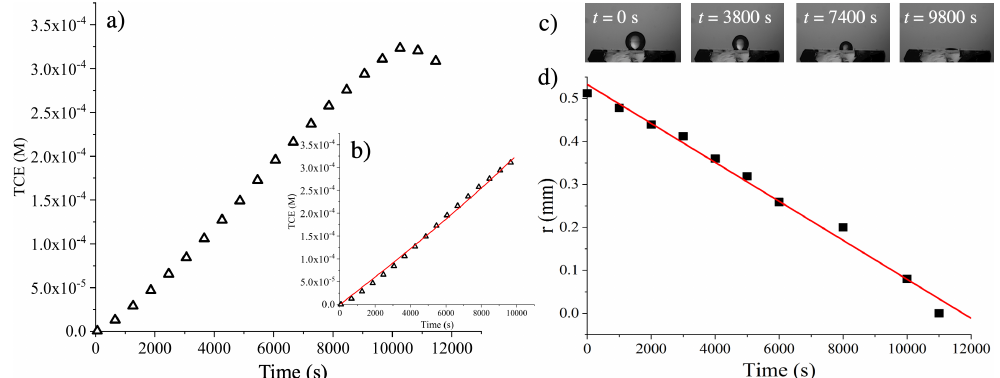
Figure 3. Experimental results in pure water. ( a ) Change of [TCE] in the bulk during an experi- ment in pure water at T = 23 ◦ C and 2010 rpm; ( b ) fitting of the experimental data by means of Equations (6) and (9) (solid red line); ( c ) snapshots of the dissolution process; ( d ) fitting of the droplet radius, by means of Equations (6) and (9) (solid red line). The radius of the droplet was measured from the experimental snapshots.